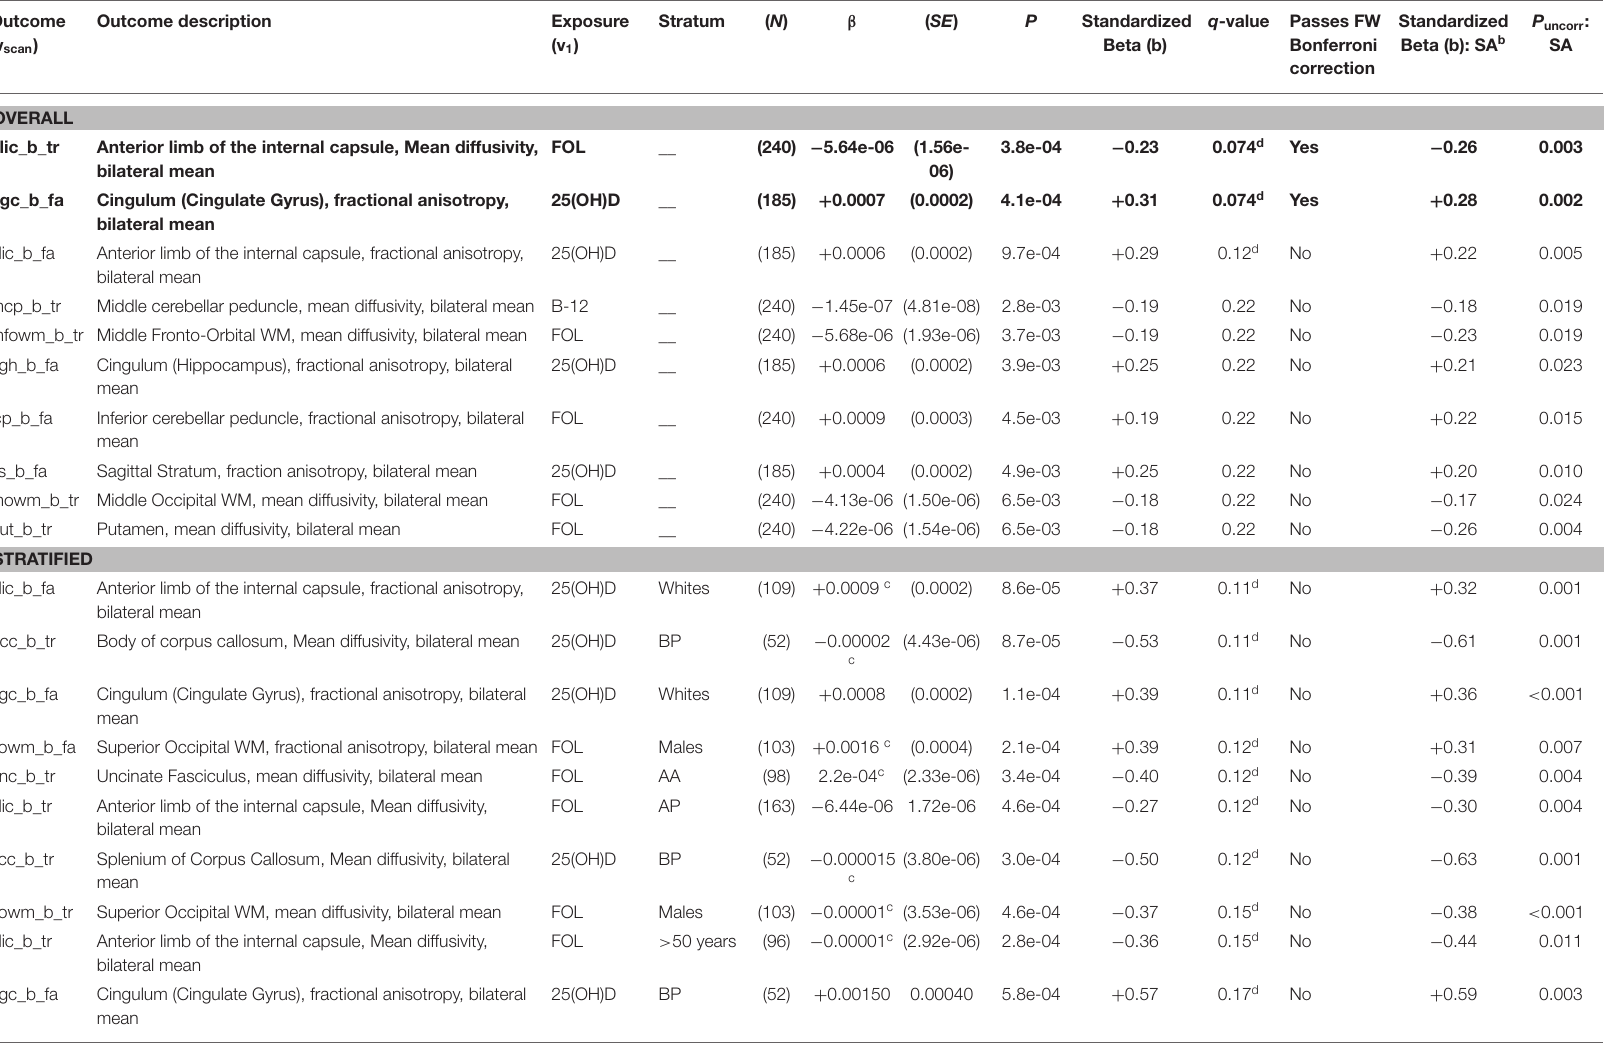
TABLE 4 | Top 10 adjusted associations from model D, bilateral means of MD and FA from dMRI vs. visit 1 exposures: serum 25(OH)D, folate and cobalamin (overall and stratified analysis) with uncorrected P < 0.05: ordinary least square brain scan-wide analyses on HANDLS 2004–2009 and HANDLS-SCAN 2011–2015 a . Outcome Outcome (v scan )